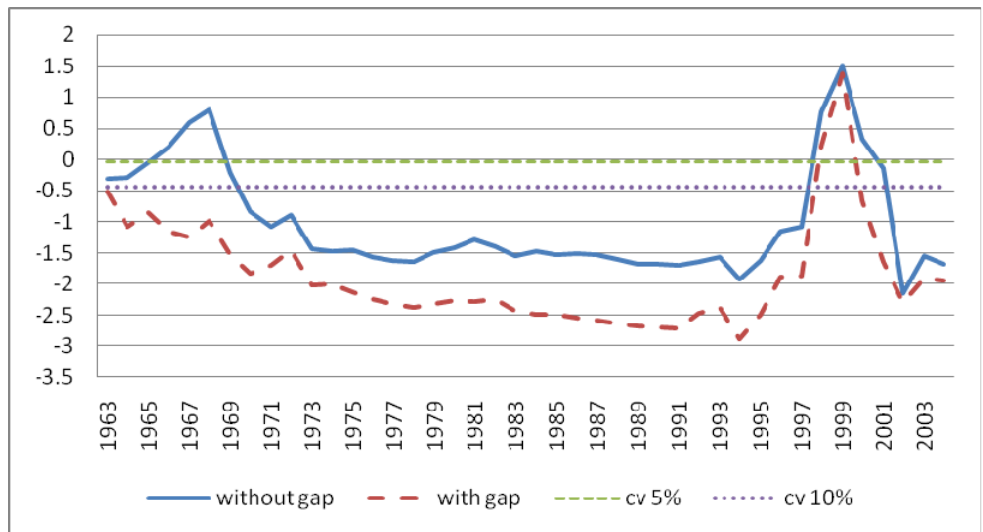
Test Statistics for S&P r